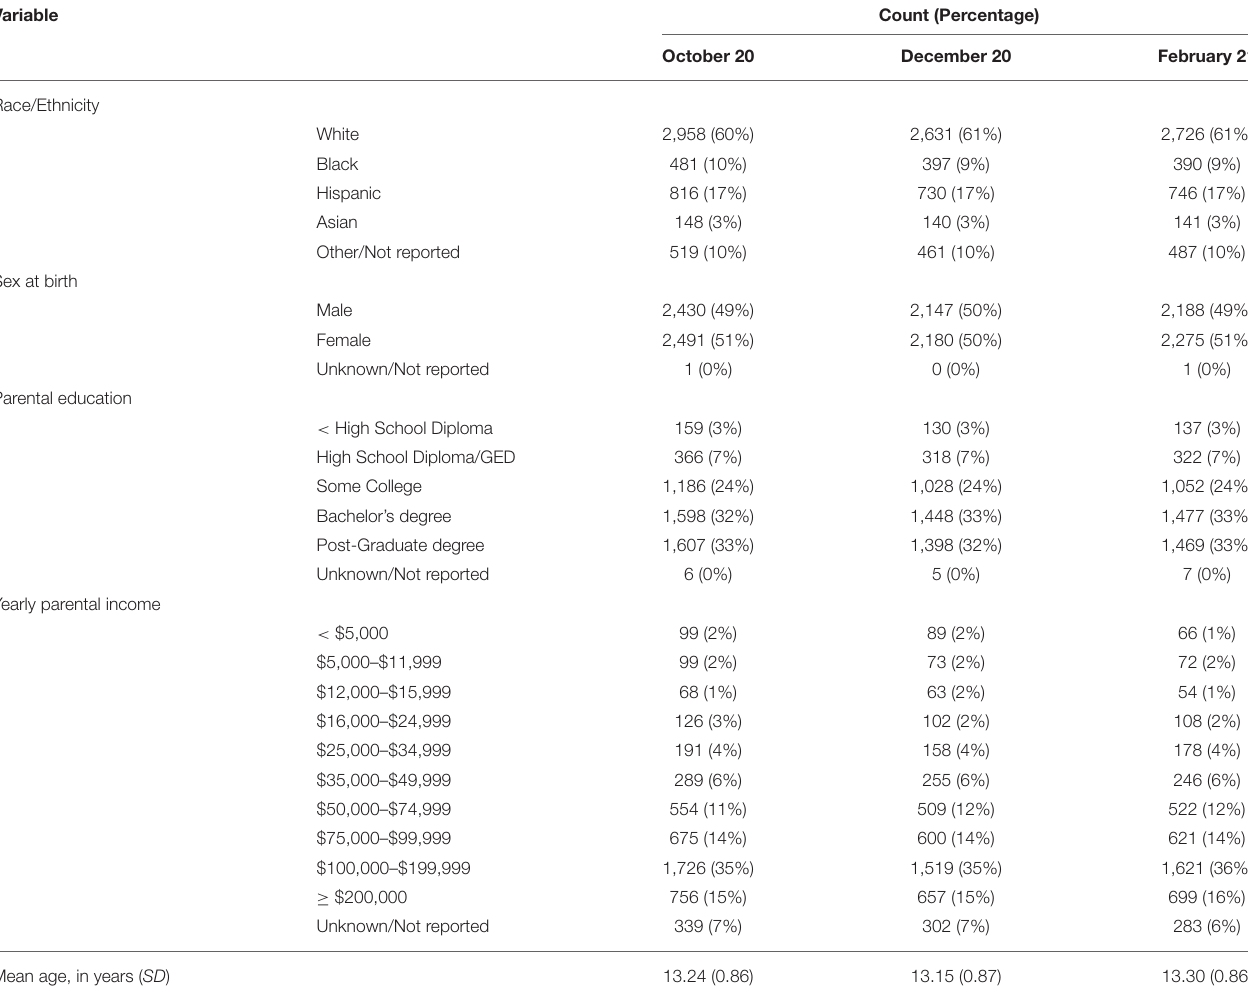
TABLE 1 | Demographics of ABCD study participants included in the current analysis.